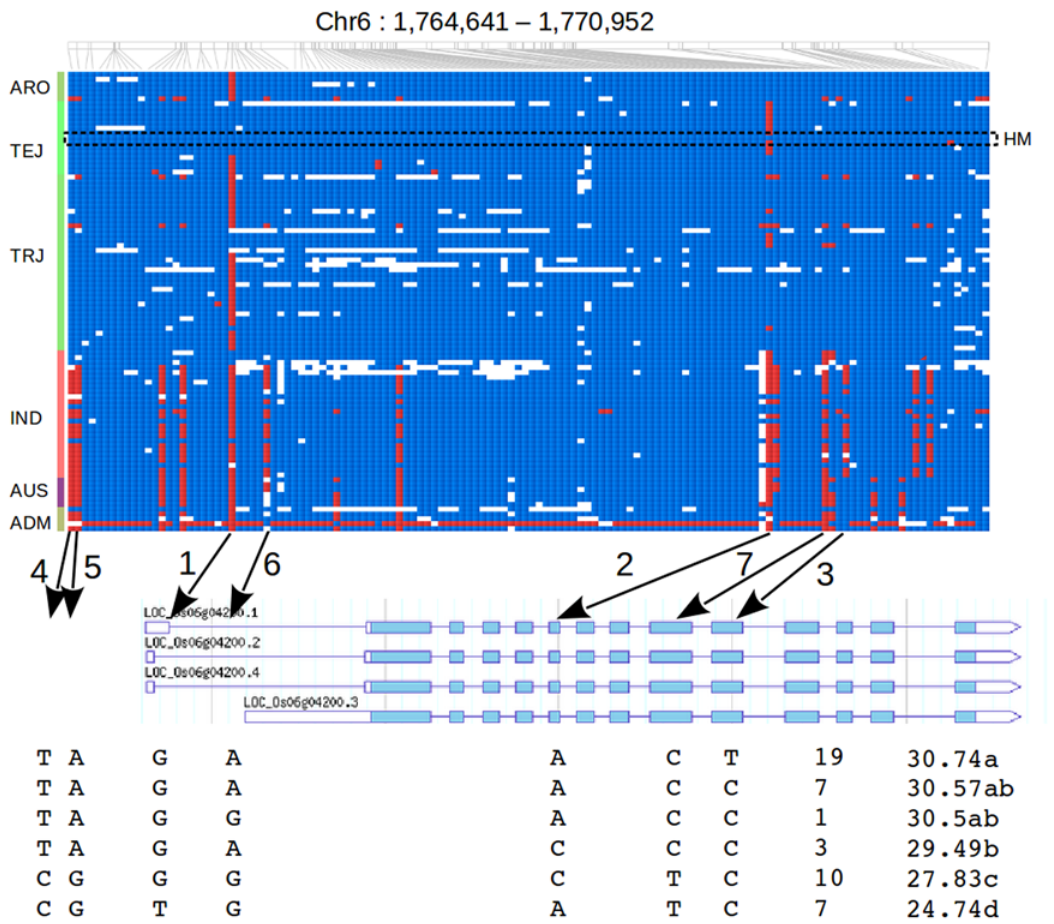
Fig 4. Observed haplotype patterns within the gene GBSSI for O. sativa accessions. Alleles of the temperate japonica variety Haginomae Mochi (dashed rectangle), which has the defective alleles for Waxy-1 to Waxy-7, are colored blue. Arrows indicate locations within the gene for the discriminative SNPs Waxy-1 to Waxy-7. Colors in the left panel differentiate the following groups: aromatic (ARO), temperate japonica (TEJ), tropical japonica (TRJ), indica (IND), aus (AUS) and admixed (ADM). The table below shows the six haplotype configurations in an independent group of 48 indica elite varieties with variable amylose contents. The last two columns are the number of samples showing the haplotype and the average amylose content for each haplotype. Characters a, b, c and d in the last column differentiate haplotypes with significant differences in amylose